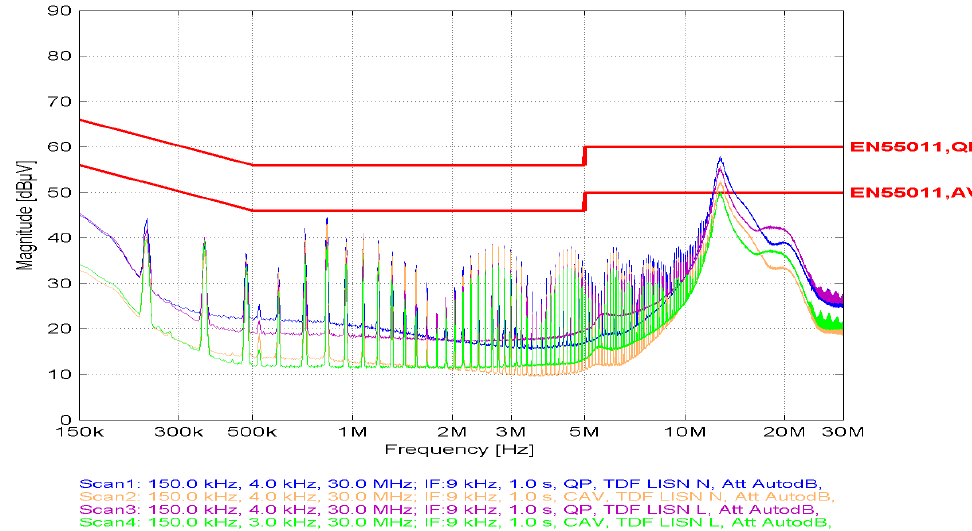
Figure 13. Attenuation level for ferrite No. 2 with the number of coils at 30 pcs. The optimal number of turns for a given ferrite no. 2 is 28 pcs (Figure 14). This means that the design level of the ferrite number can be reduced by 11 pcs. Without any impact on the attenuation efficiency. The reduced number of turns for ferrite No. 2 (11 pcs) is greater than that of ferrite No. 1 (9 pcs). However, in percentage terms, greater reductions in the number of turns were obtained in the case of ferrite No.